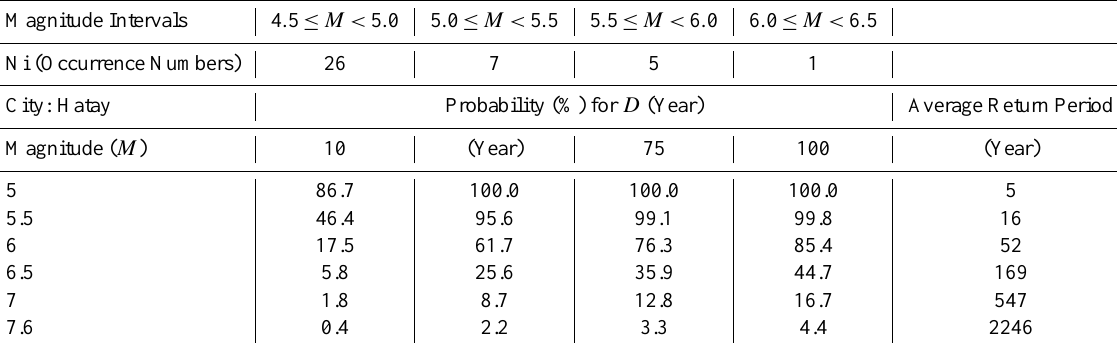
Table 3k. Earthquake occurrence probability (%) for D (Year) for Hatay city. Magnitude